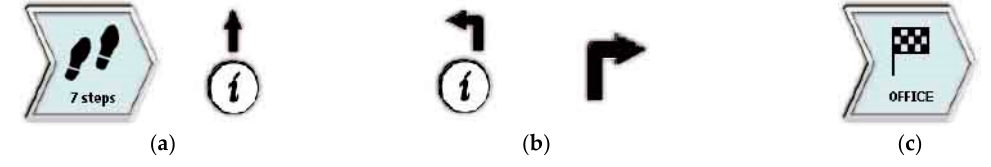
Figure 2. Examples of activity-based instructions: ( a ) Go straight for seven (7) steps to the information desk; ( b ) Turn left/right to the information desk; ( c ) Stop at the destination.